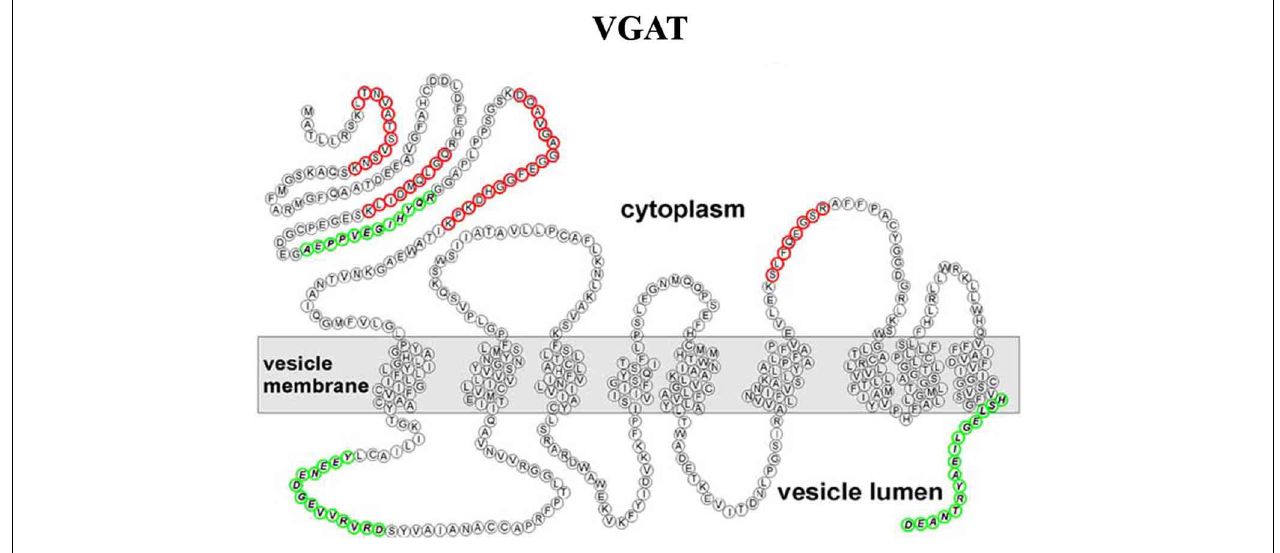
FIGURE 5 | Refined transmembrane topology of the vesicular GABA transporter (VGAT), the only member of the SLC32 gene family (Martens et al., 2008).